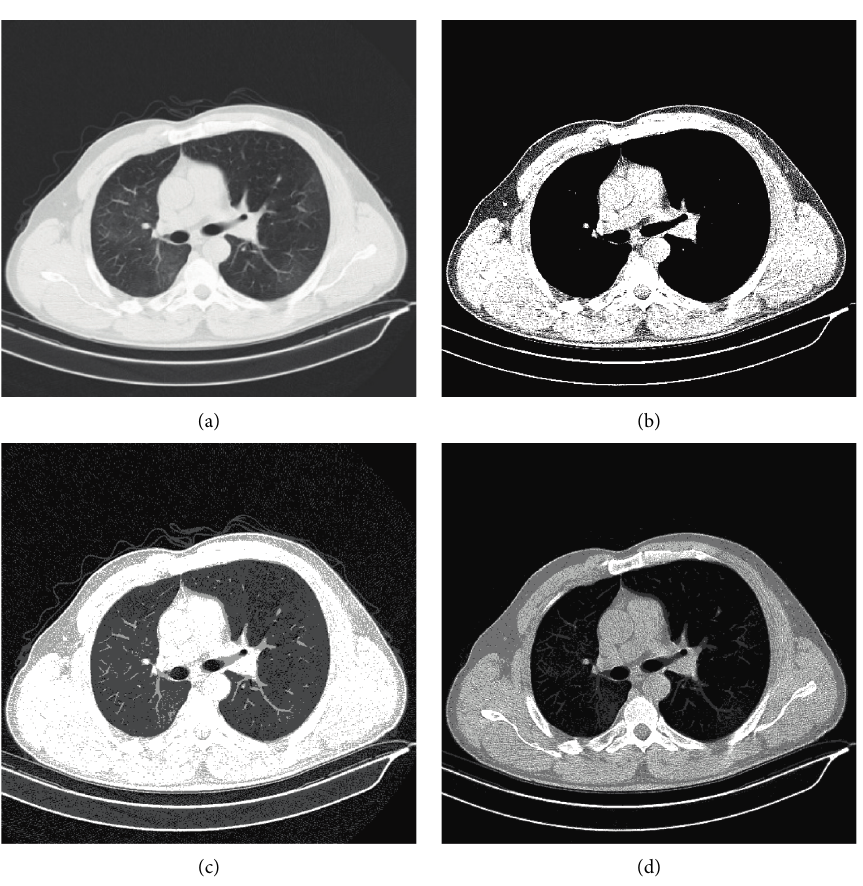
Figure 5: CT image-4 segmentation results of three threshold levels using the proposed approach. (a) Original CT image, (b) level-2 threshold Segmentation, (c) level-3 threshold segmentation, and (d) level-4 threshold